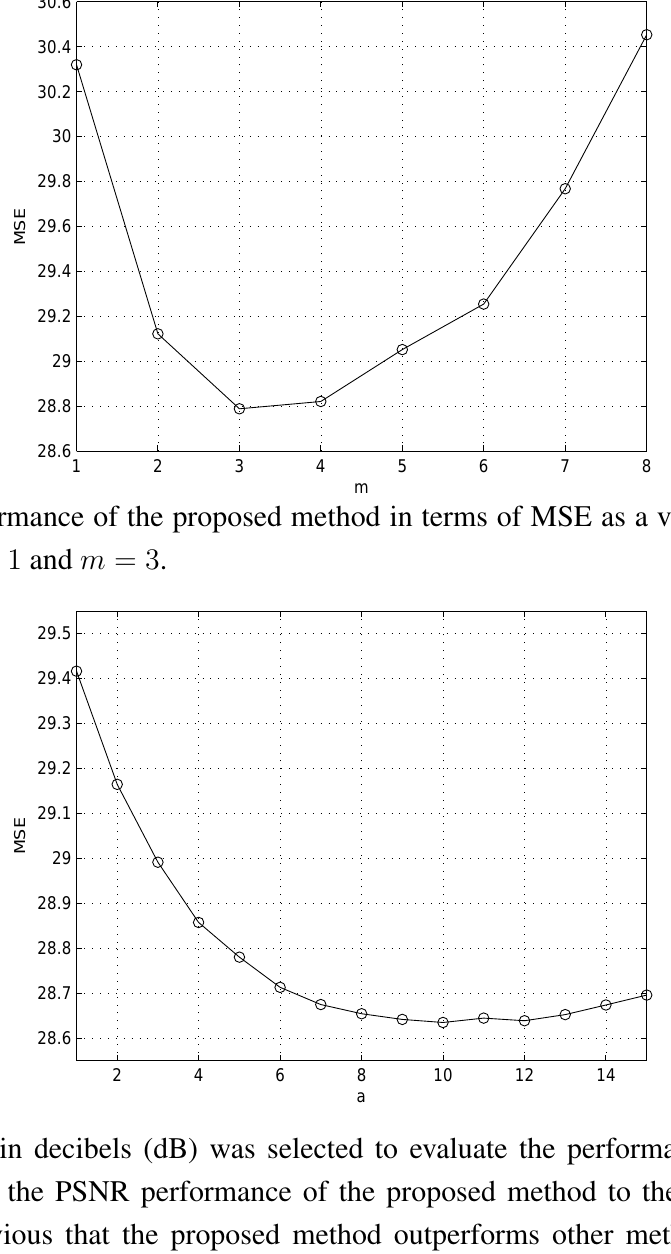
Figure 2. Performance of the proposed method in terms of MSE as a value of m under the condition of b = 1 , for 1 ≤ a ≤ 15 .